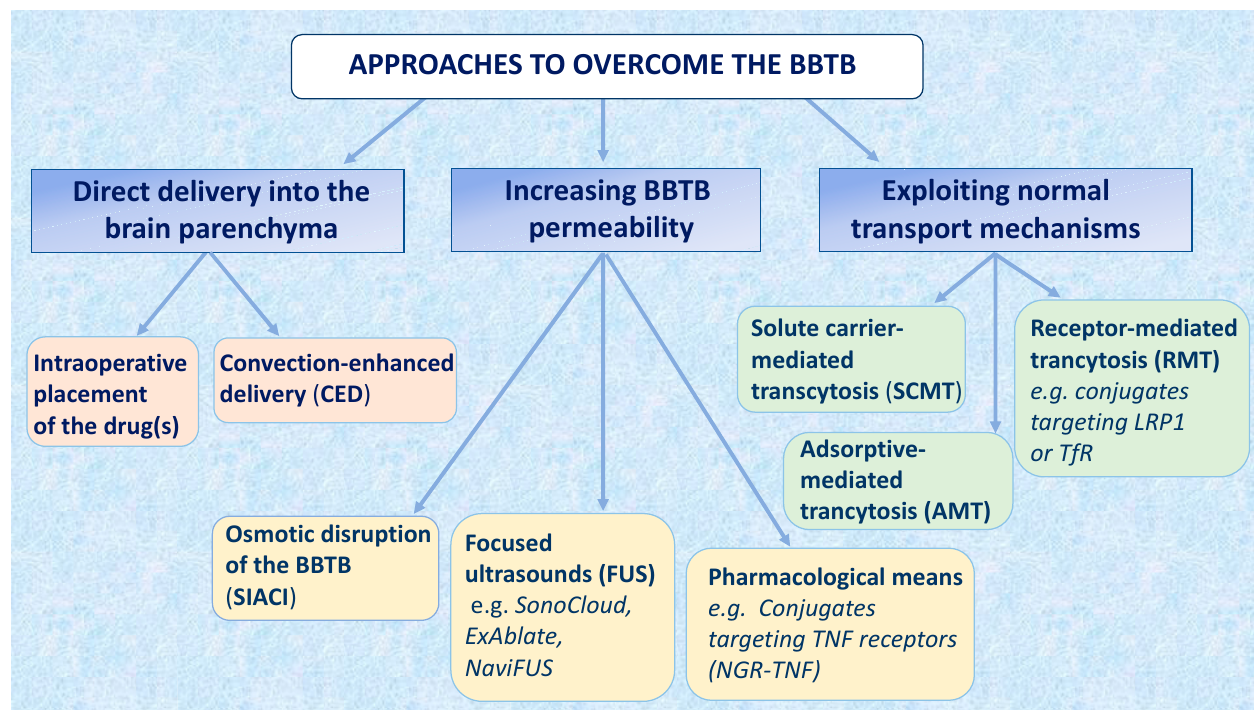
Figure 1. Approaches to overcome the BBTB. Three main classes of approaches to overcome the BBTB are shown. Each class is divided in different subclasses. Abbreviations: BBTB, blood–brain tumor barrier; FUS, focused ultrasound; SCMT, solute carrier-mediated transcytosis; SIACI, superselective intraarterial cerebral infusion; Tfr, transferrin receptor; TNFR, tumor necrosis factor receptor.